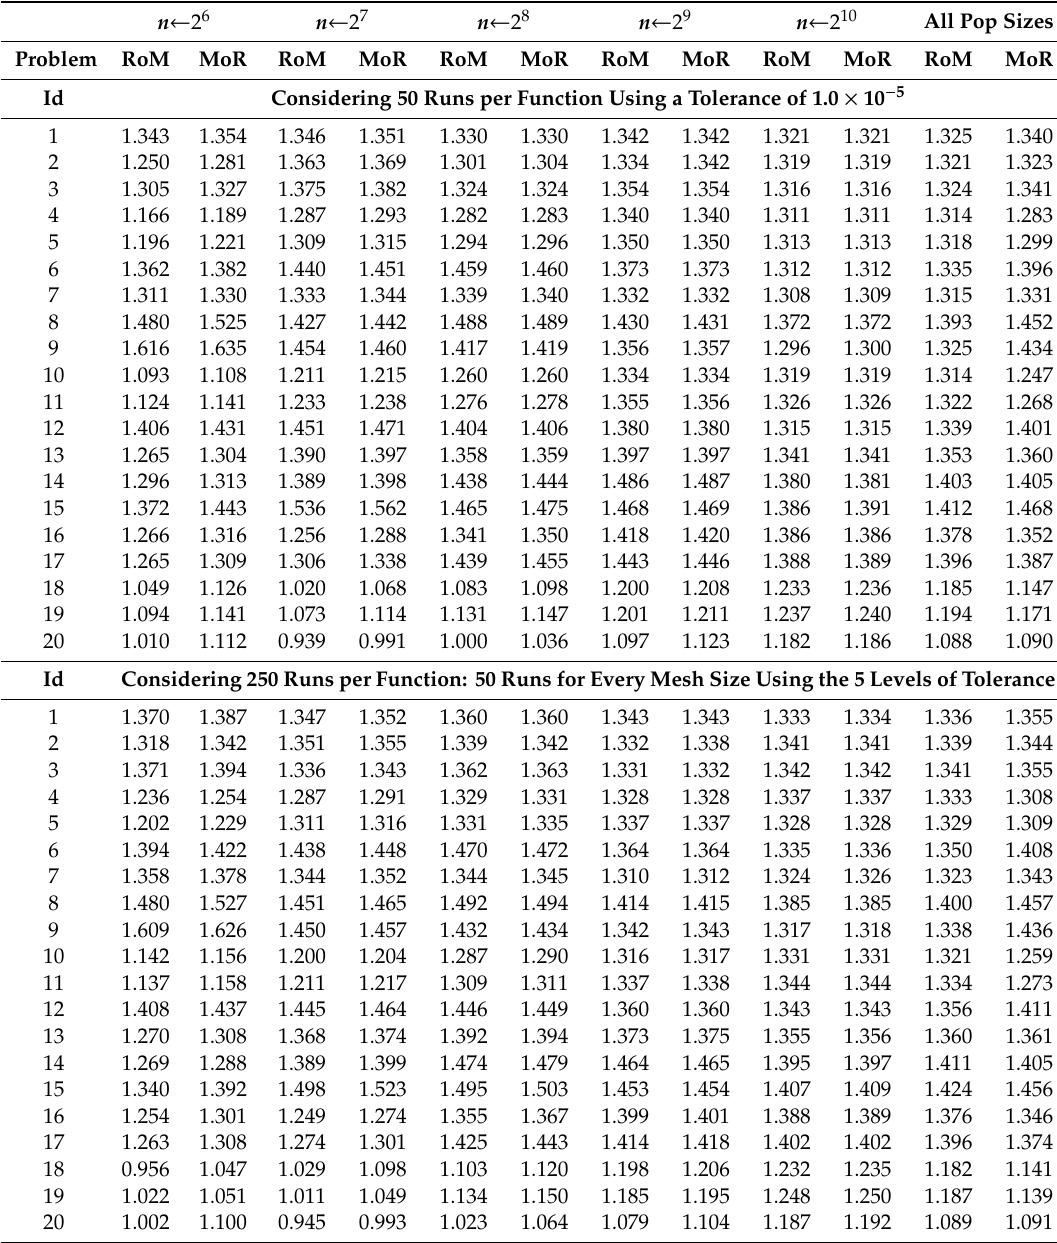
Table A2. Individual values of ratio of means (RoM) and mean of ratios (RoM), for 50 runs and 250 runs of HVcMO20a and HillVallEA19 over each test problem with populations of di ff erent